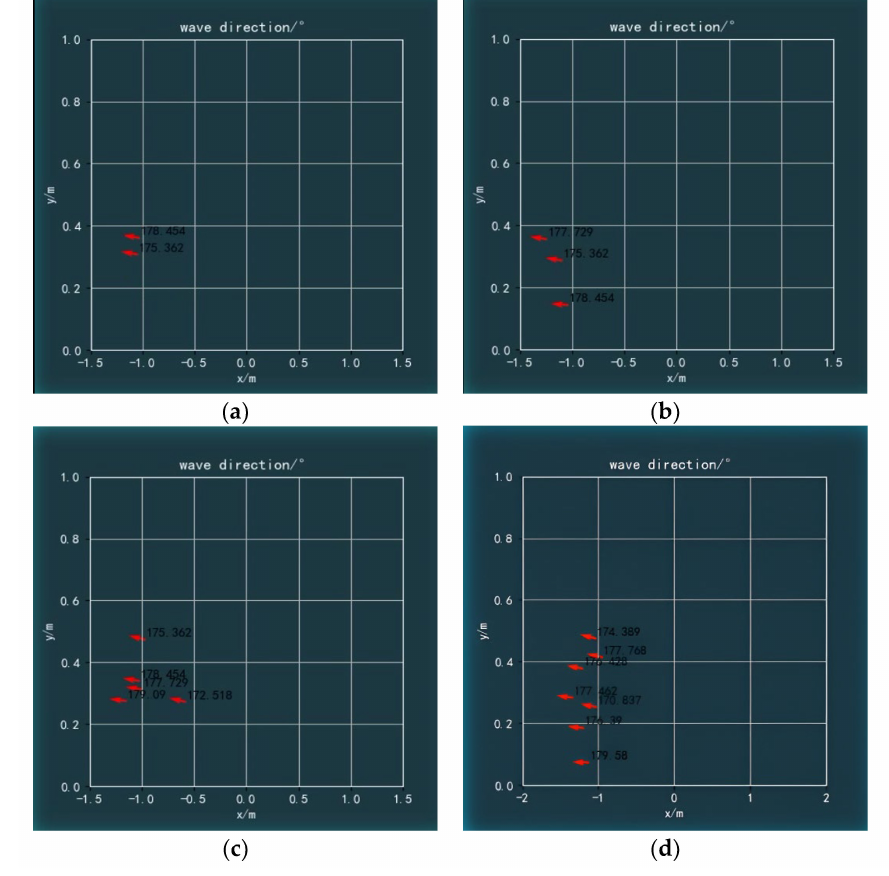
Figure 12. Illustration: ( a ) wave direction diagram of the first image frame; ( b ) wave direction diagram of the second image frame; ( c ) wave direction diagram of the third image frame; ( d ) wave direction diagram of the thirteenth image frame.